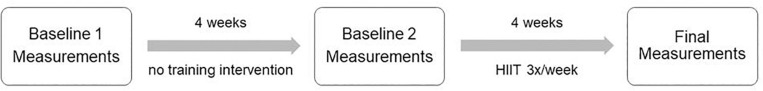
Study flowchart.